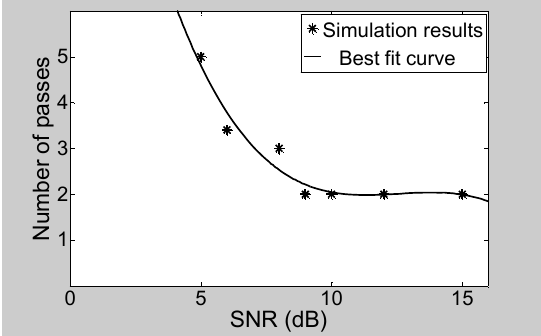
Figure 21. Variation in required number of passes as a function of